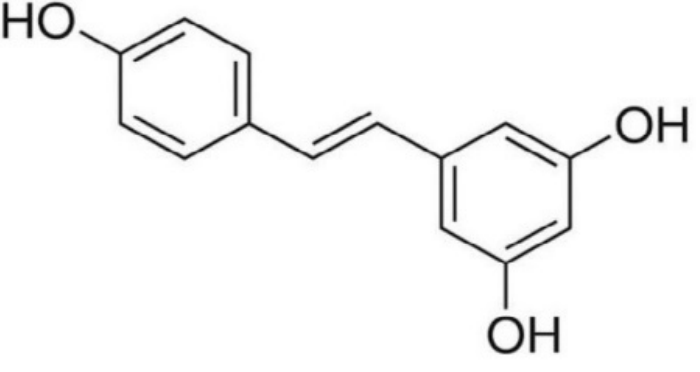
Figure 5. Structural formulas of resveratrol.